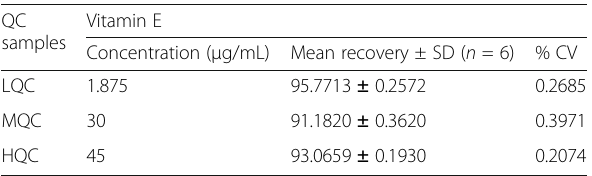
Table 7 Percentage recovery of vitamin E for developed bioanalytical method QC Vitamin E samples